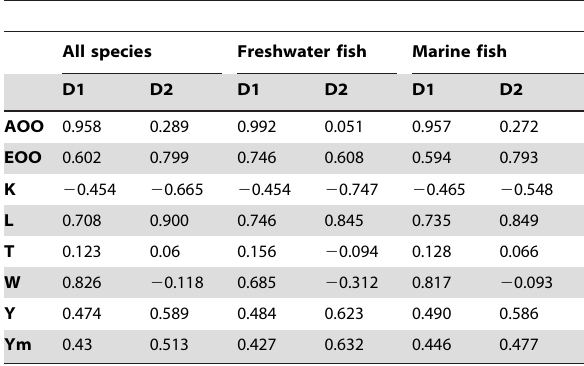
Table 2. Canonical loadings for the first two dimensions of CANCORs for freshwater and marine fish species.